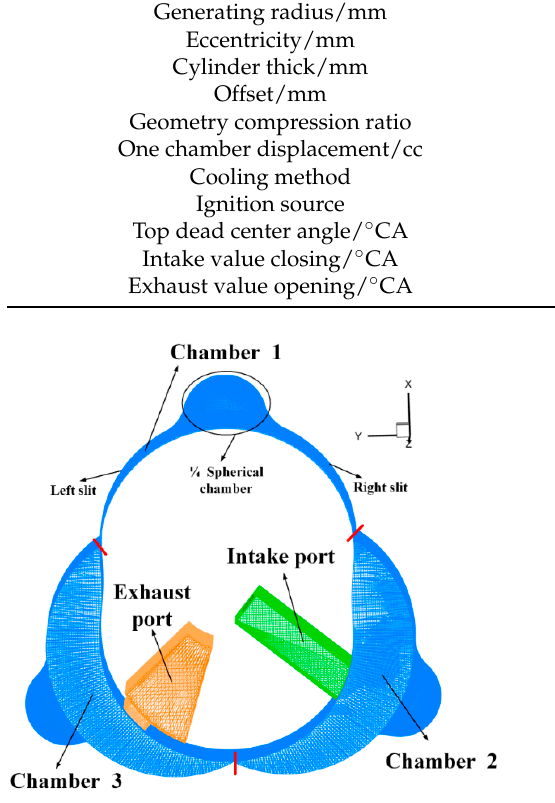
Figure 2. Grid division of XRE.